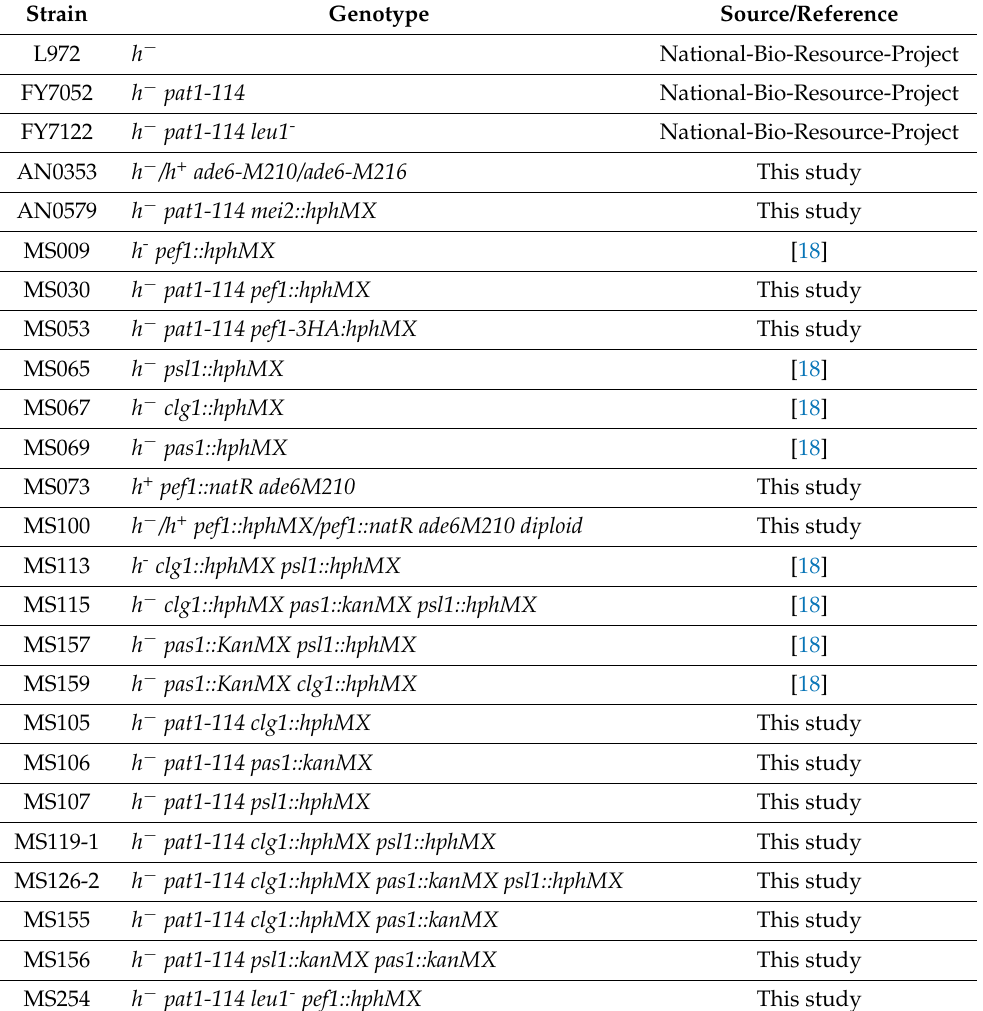
Table 1. S. pombe strains used in this